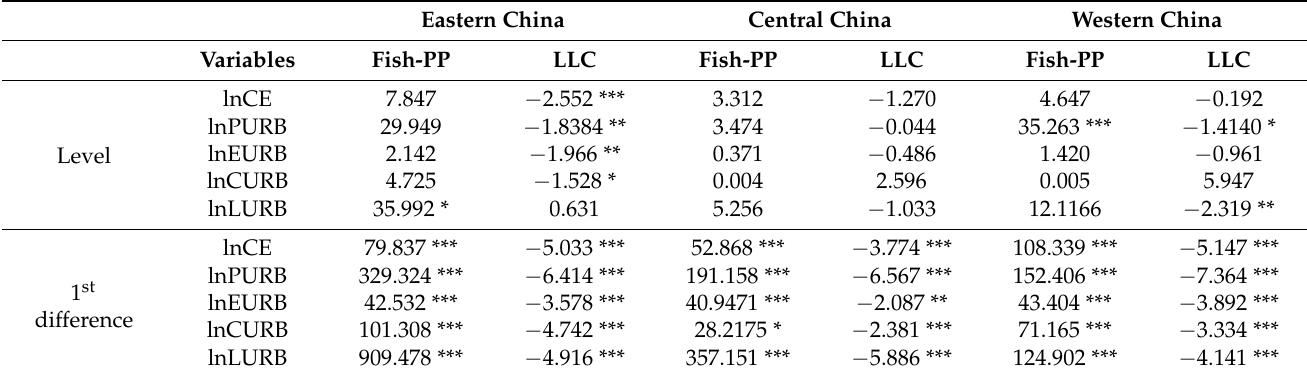
Table 4. Unit root test results of panel data of eastern, central, and western China.